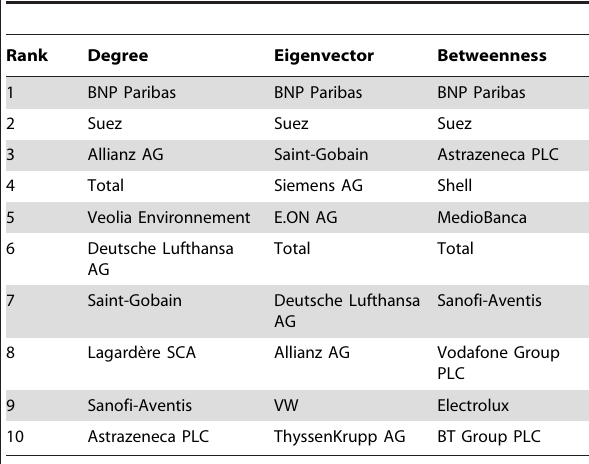
Table 2. Top 10 ranked firms with respect to three different measures of centrality – Year 2005.